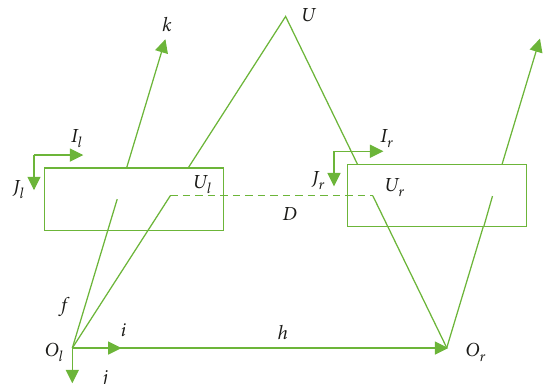
Figure 1: Binocular vision measurement